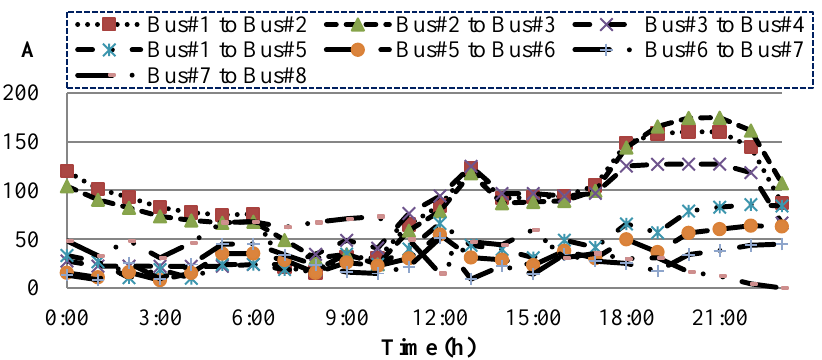
Figure 10. Numerical results of current flow under grid-tied operation.